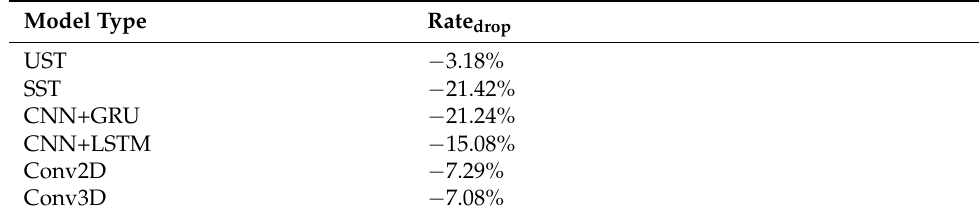
Table 7. Rate drop s of six backbones on four task-sets. Model